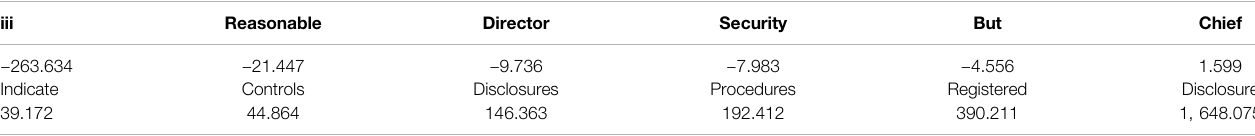
TABLE 3 | Words picked by the LASSO,